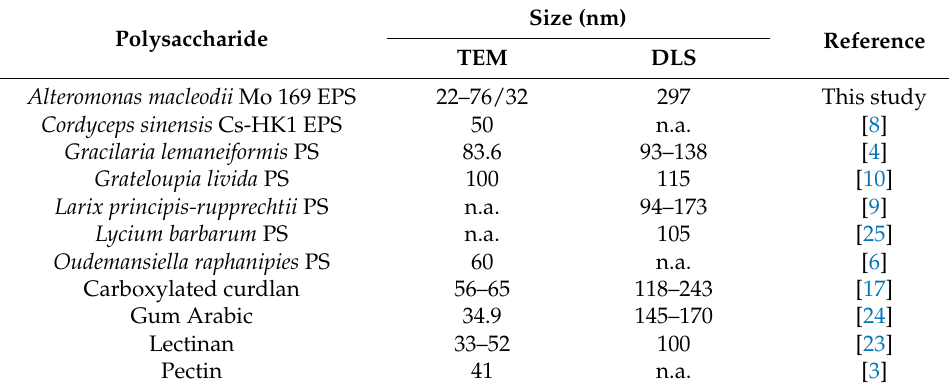
Table 1. Particle size of the SeNPs (determined by TEM analysis) prepared with different polysac- charides and the respective polysaccharide/SeNPs bio-nanocomposites (determined by DLS) (PS, polysaccharide; n.a., not